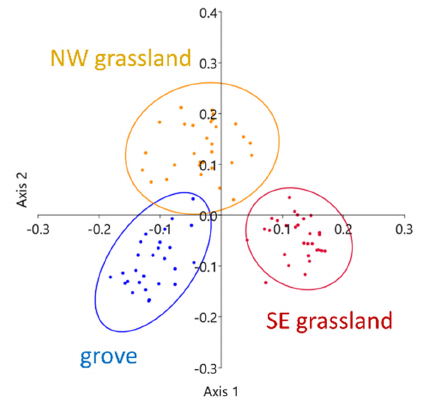
Figure 9. PCoA ordination of microcoenological data from the SE–NW transect. Jaccard index was used on summer measurements. Ellipses representing 95 % confidence are drawn according to vegetation patch.